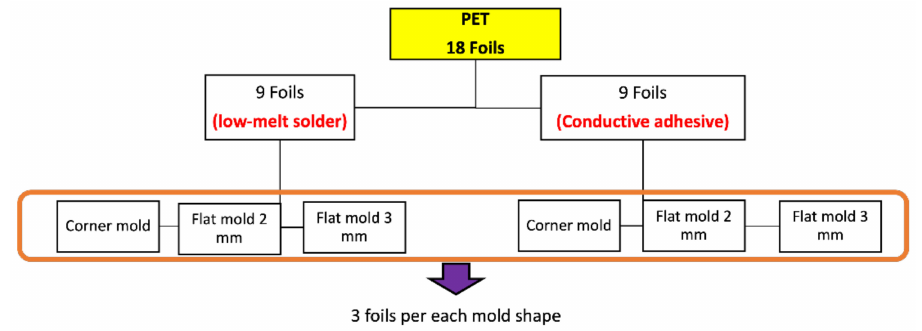
Figure 10. Overview of used PET-Cu